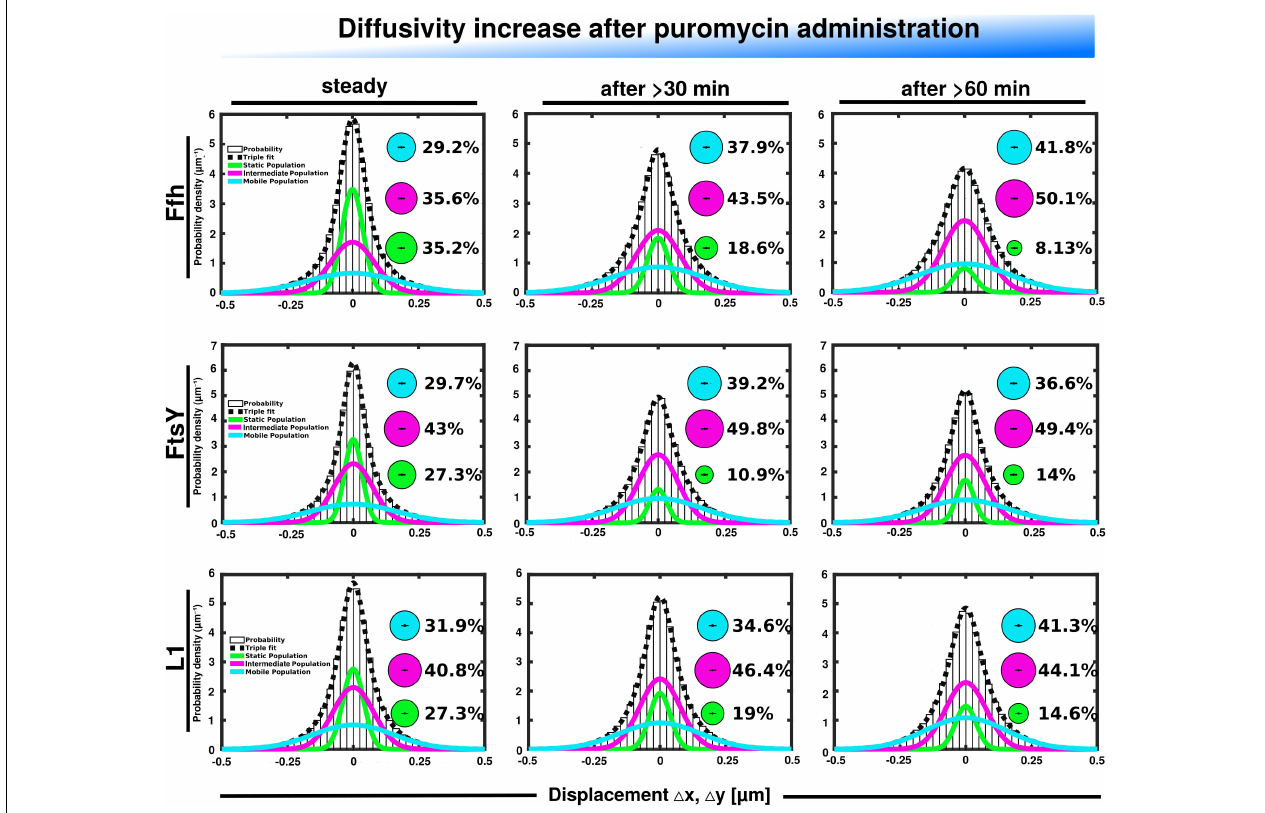
FIGURE 6 | GMM analyses after addition of puromycin, leading to premature translation termination and mRNA release. GMM analysis identifies three significantly distinct diffusive subpopulations indicated by the different colored lines, dashed line shows sum of the three fits. Bubbles illustrate fraction